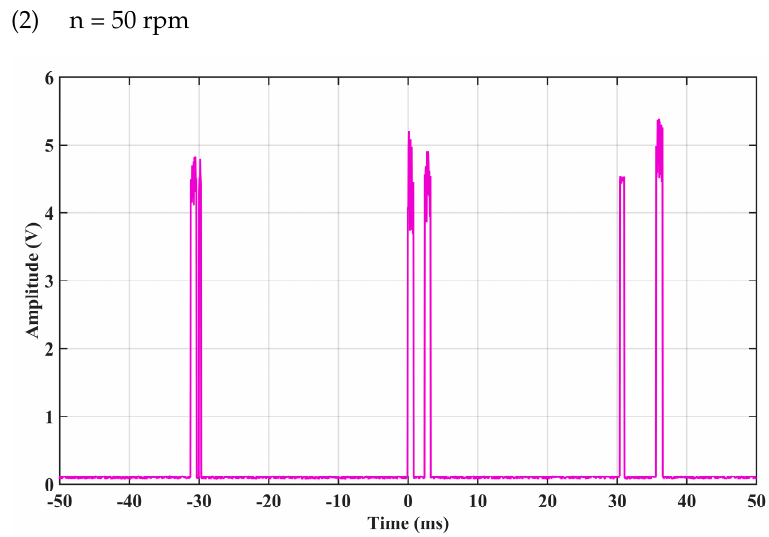
Figure 3. The 50 rpm oscilloscope waveform.